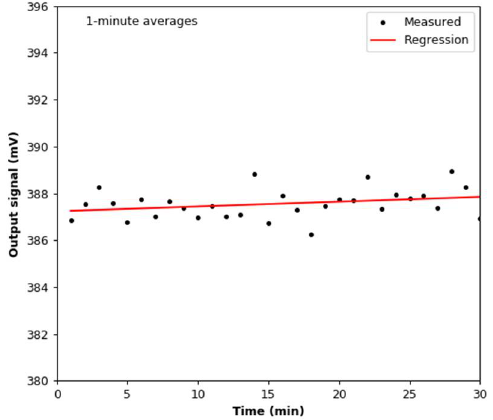
Figure 5. Variations in the output signal during the stability test: 1- min